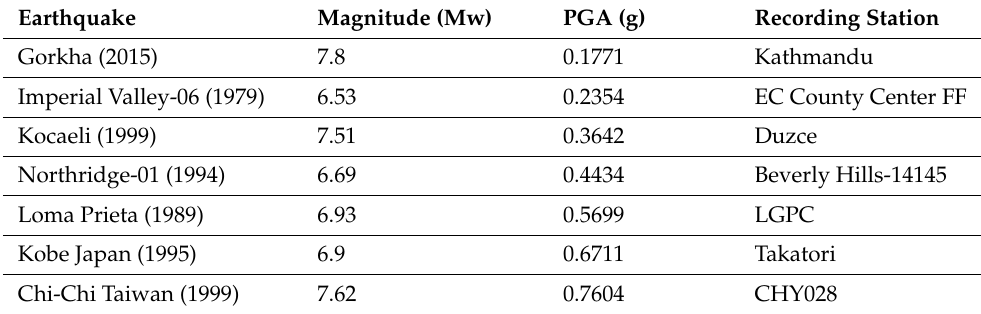
Table 3. Ground acceleration time histories used for nonlinear time history analysis.